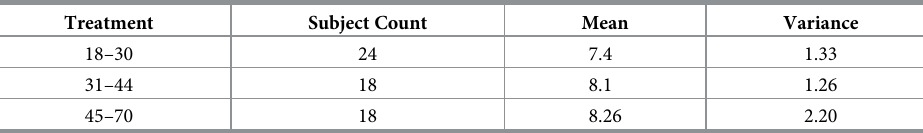
Table 27. Data summary—Viewpoint